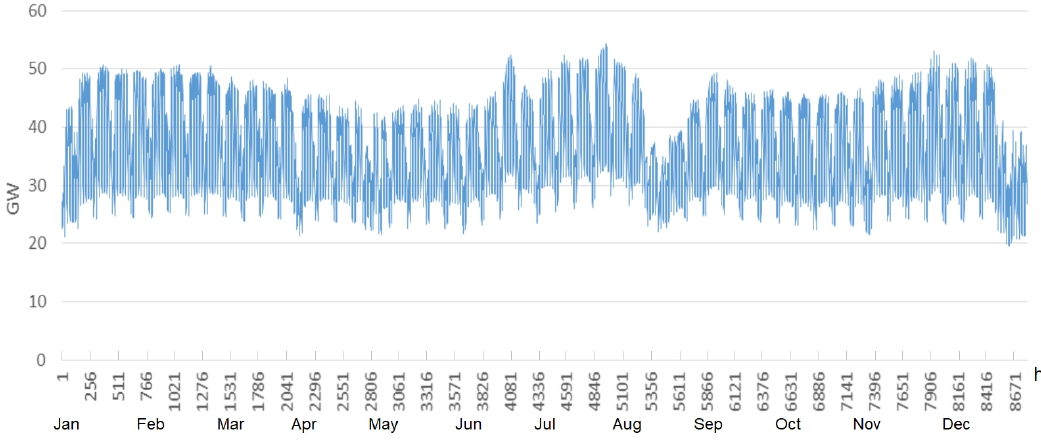
Figure 1. Hourly electricity demand of Italy in 2013.